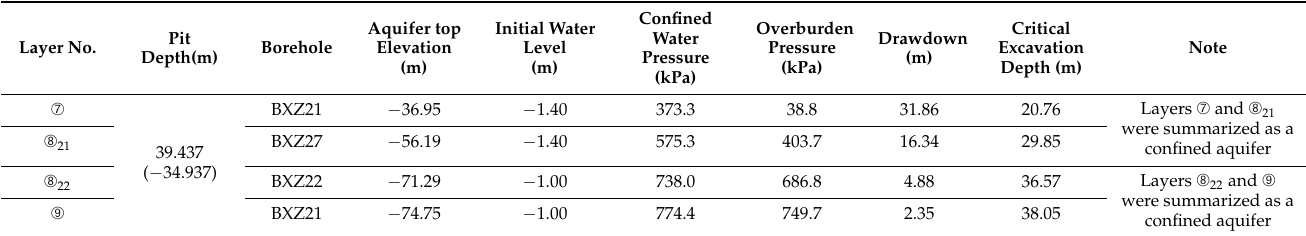
Table 1. Checking calculation of anti-gushing stability of each confined aquifer of the No. 4 Founda- tion Pit (safety factor is